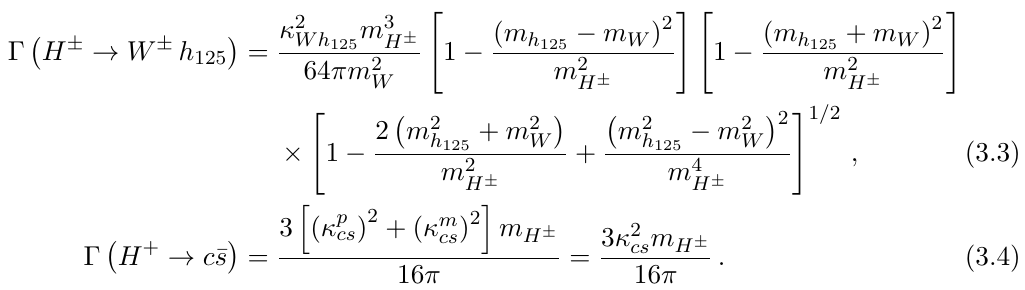
Figure 1 . (cid:27) ( pp tree-level partial widths are given